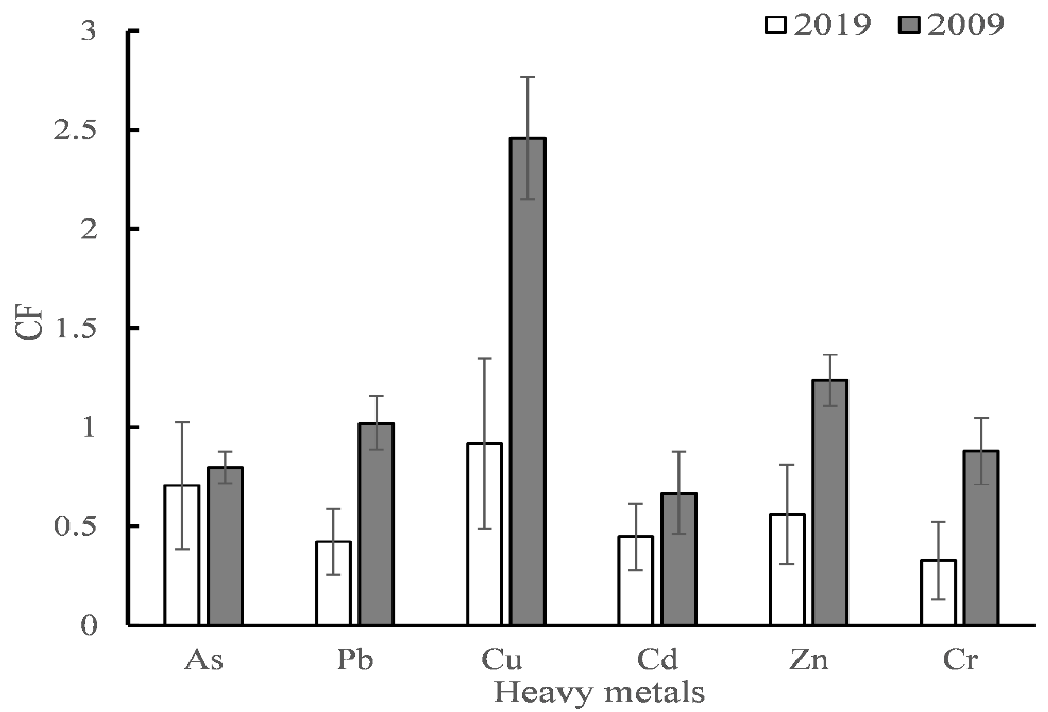
Figure 5. CF values of heavy metals calculated from data in 2019 and that of 2009 from literature [32].